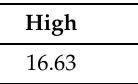
Table 1. Distribution of nightlight intensity